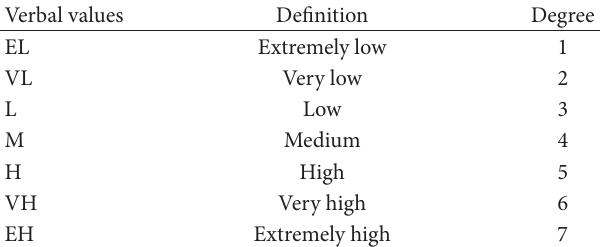
Table 2: Linguistic definition of verbal